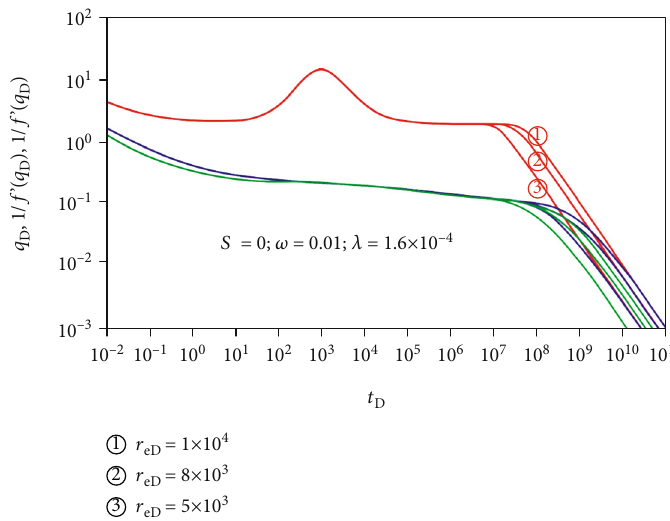
eD , on type curves.